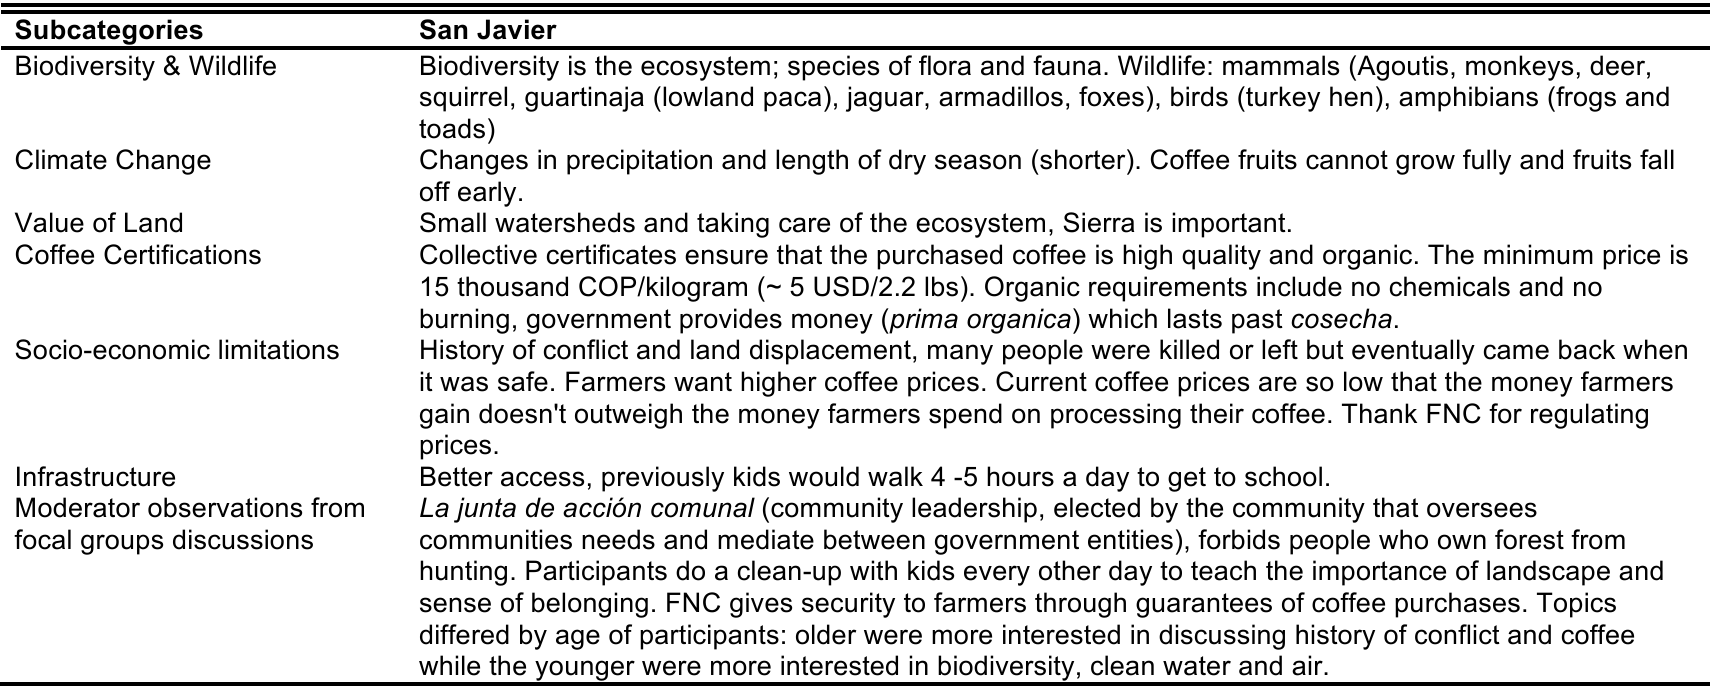
Table A2.3 The community of San Javier (n=7) presented